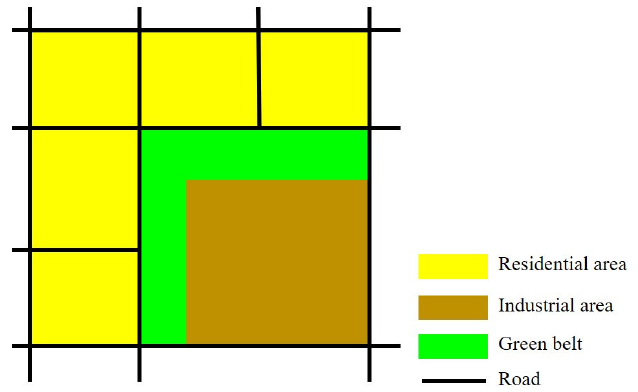
Figure 5. Planning strategies for the spatial layout of industrial areas.